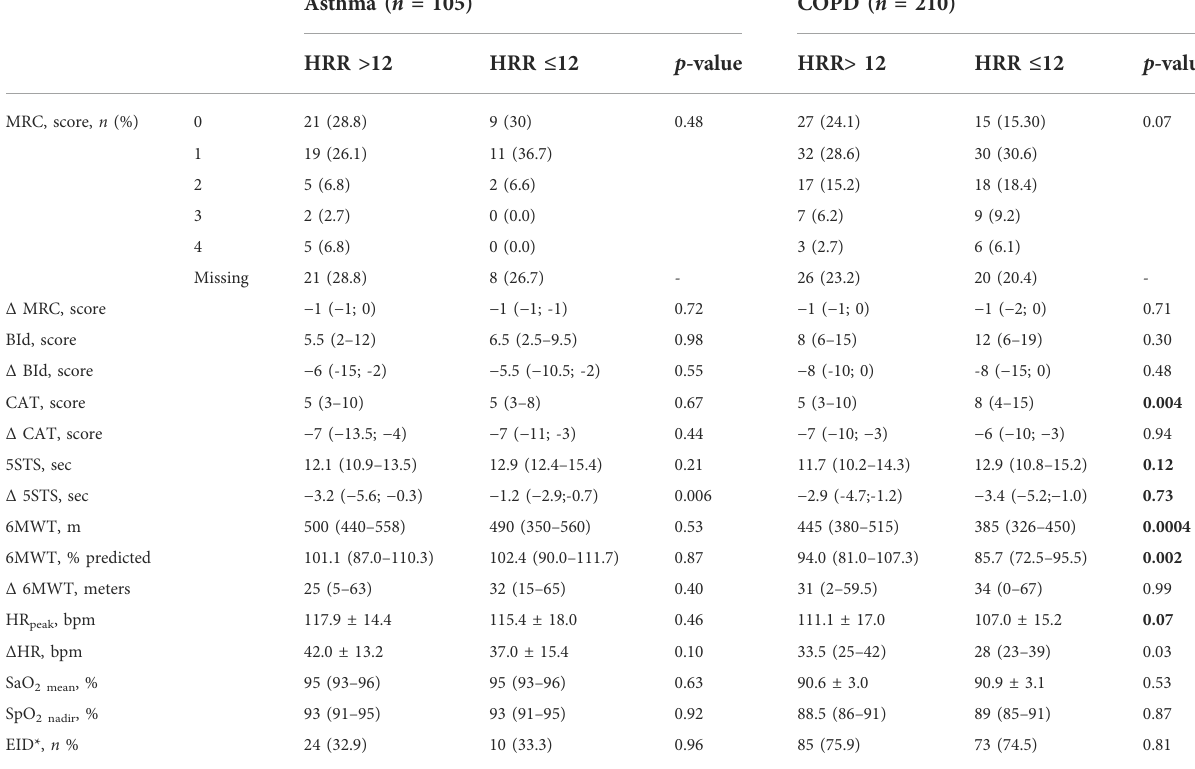
TABLE 4 Post pulmonary rehabilitation values of and changes in outcome measures according to